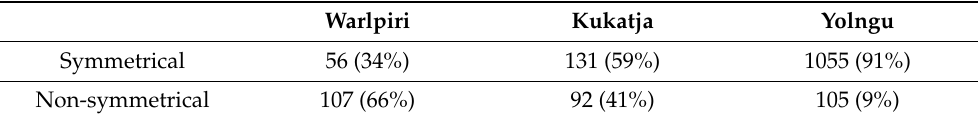
Table 4. Symmetry and asymmetry in two-handed sign tokens in Warlpiri, Kukatja and Yolngu SLs.